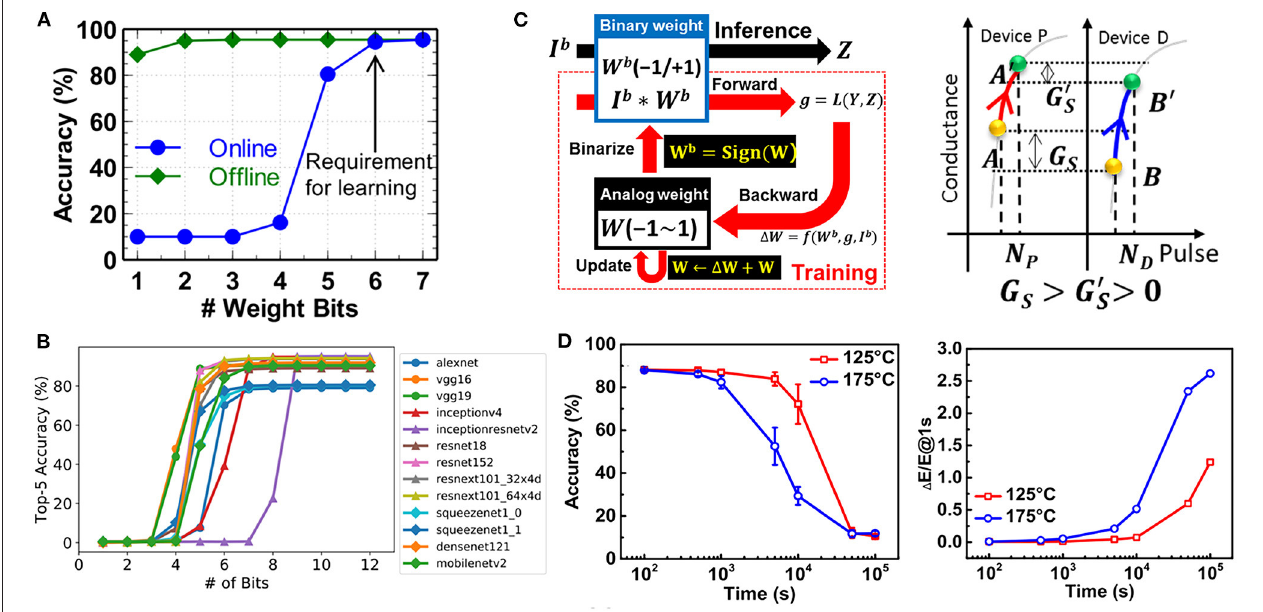
FIGURE 7 | (A) Impact of weight precision on accuracy in a two-layer fully neural network for MNIST dataset. (B) Impact of weight precision on accuracy of representative DNNs. (C) Schematic of binarized neural network (BNN) algorithm and the typical example of weight accumulation process. (D) Recognition accuracy and normalized energy consumption change as a function of baking time. Reprinted from Chen et al. (2017), Yang and Sze (2019), Zhou et al. (2018), and Xiang et al.